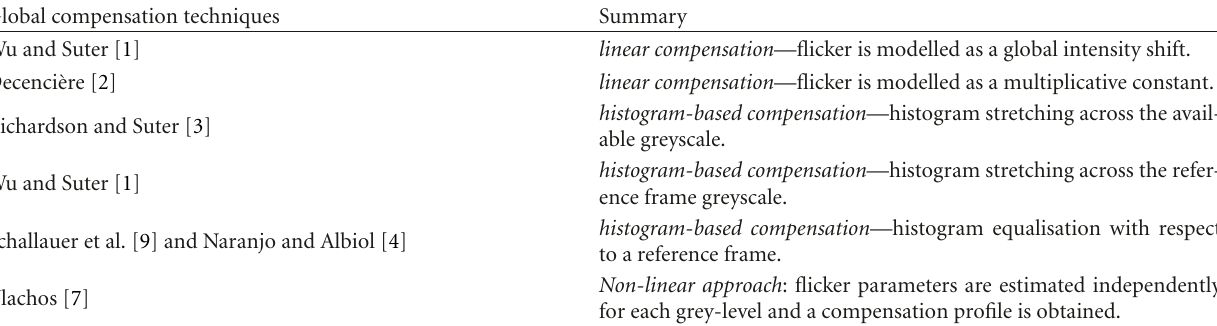
Table 1: An overview of the global flicker compensation techniques.